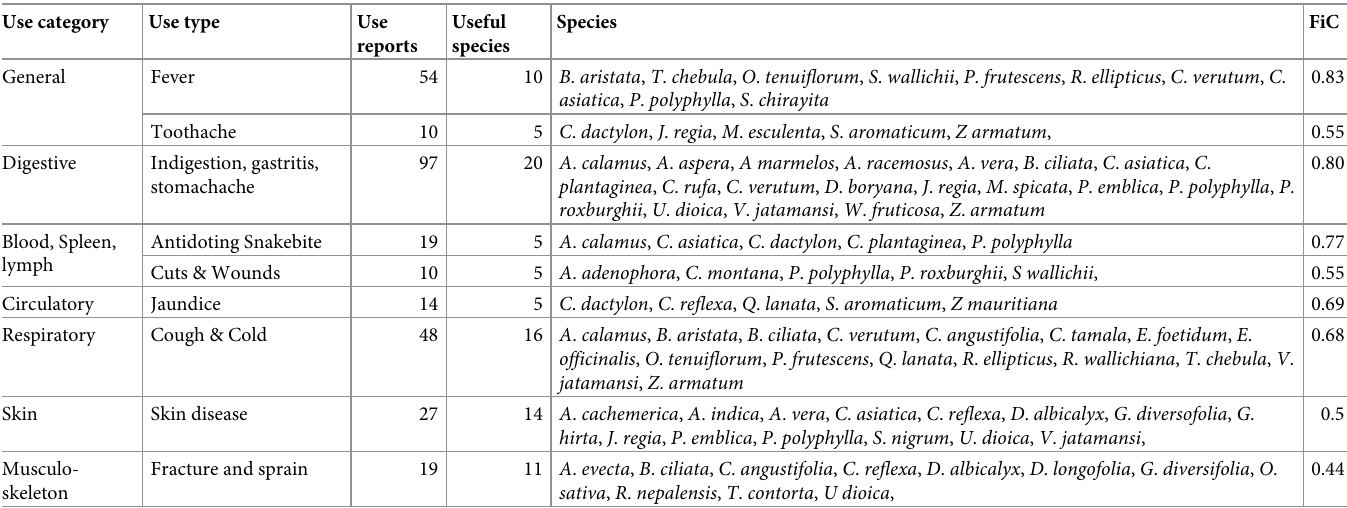
Table 2. Use categories, types and reports and informant consensus factor